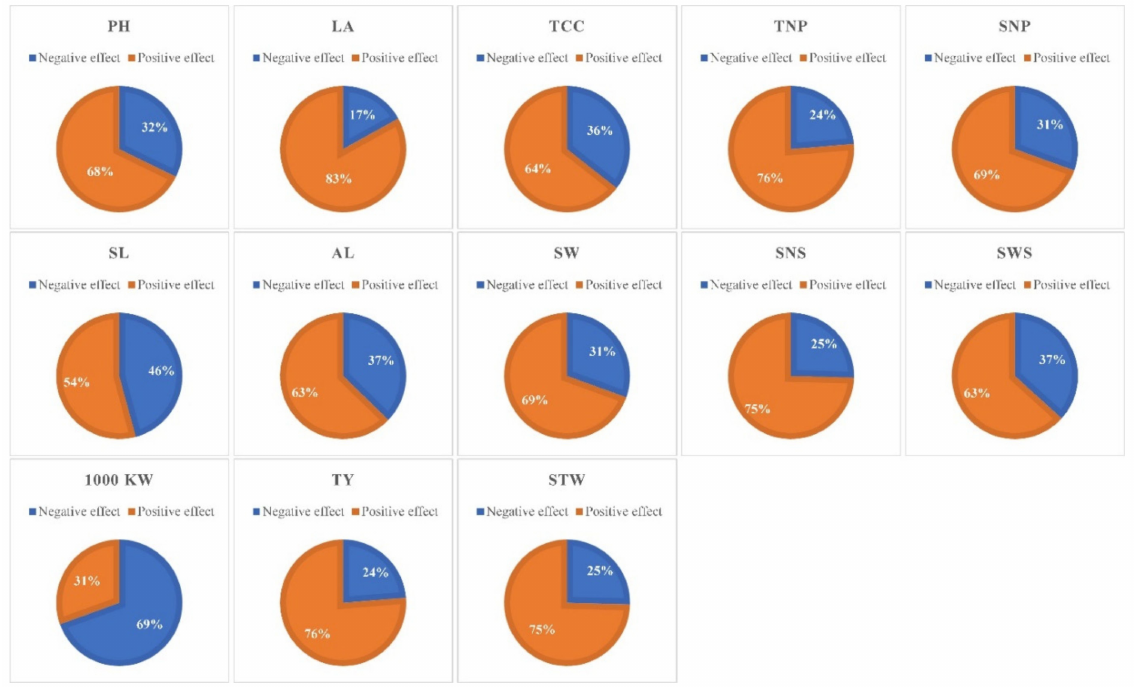
Figure 7. Illustration of the proportion of positive and negative effects of MOE application on the studied traits, based on the responses of 59 barley